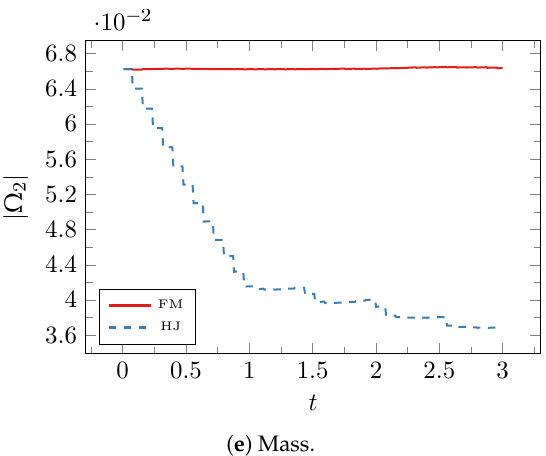
Figure 10. Comparison between the Fast Marching method (FM) and the Hamilton-Jacobi (HJ) method for test case 2 (skirted drop). The characteristic mesh size is h = 0.0175.